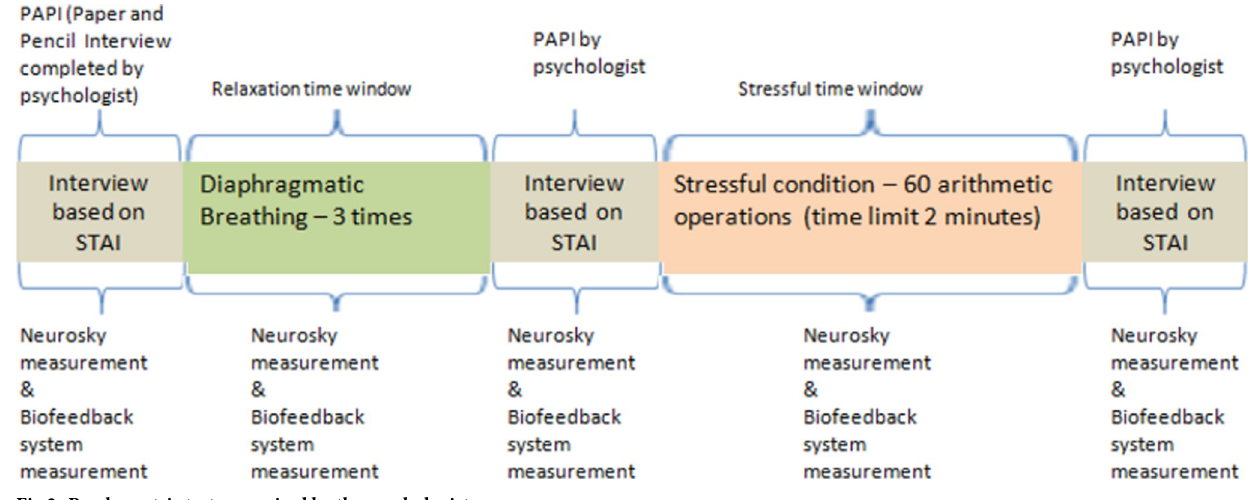
Fig 2. Psychometric test supervised by the